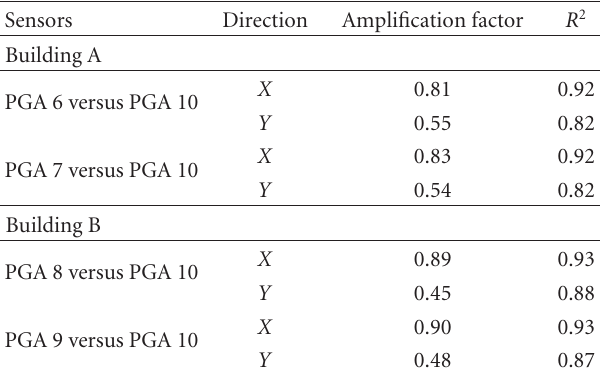
Table 1: Maximum PGA and PRA recorded by individual sensors. Sensor